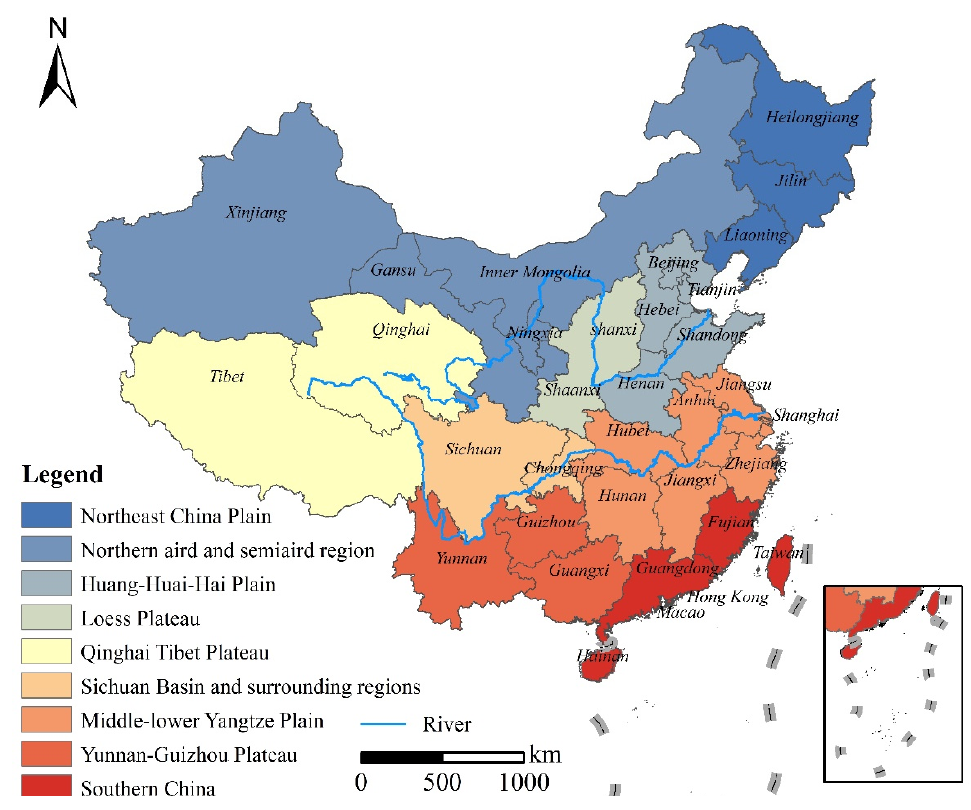
Figure 1. Map of agricultural regions in China.